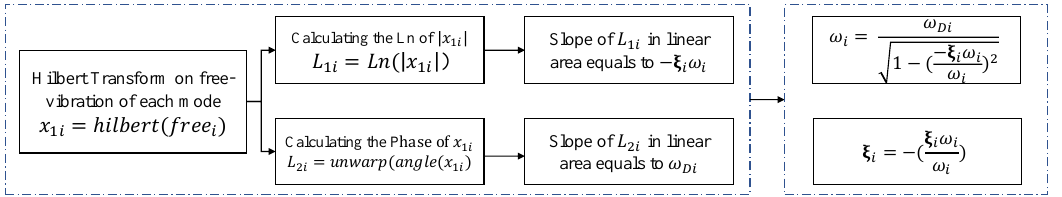
Figure 12. Algorithm to determine ξ i and ω i